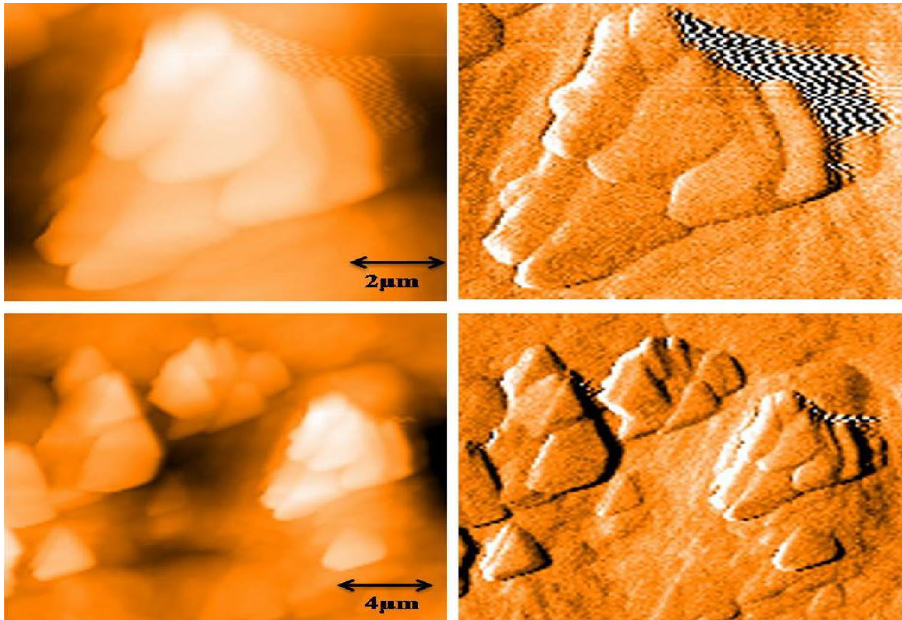
Figure 5. Atomic Force Microscope image of mangostan peel mediated synthesized gold nanoparticles at 2 µm and 4 µm.